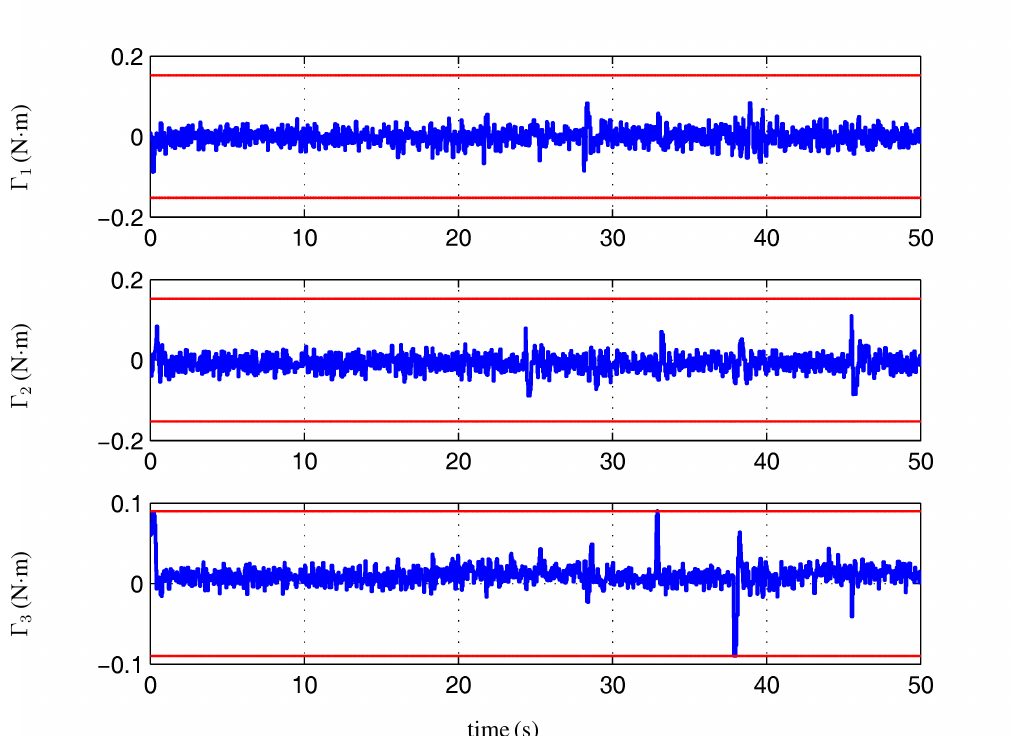
Figure 10. The bounded control torques of Corollary 1. The red dashed lines define the bounds of the control